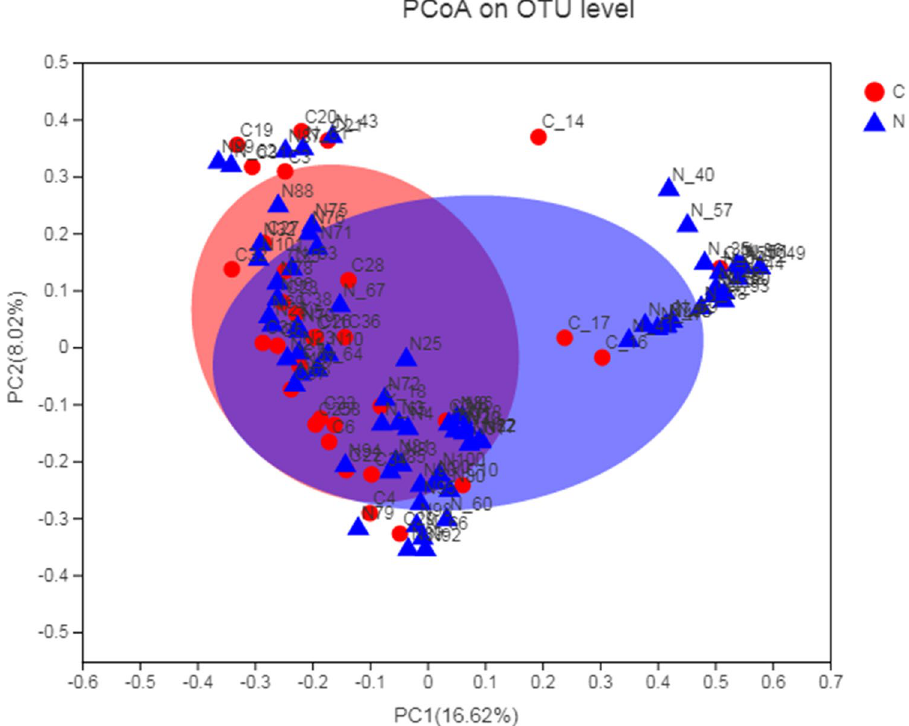
Figure 1. A principal coordinates analysis (PCoA) of bacterial communities was calculated with non- constrained data dimensionality reduction analysis method. The plots’ central tendency indicates the interpersonal variability of the two